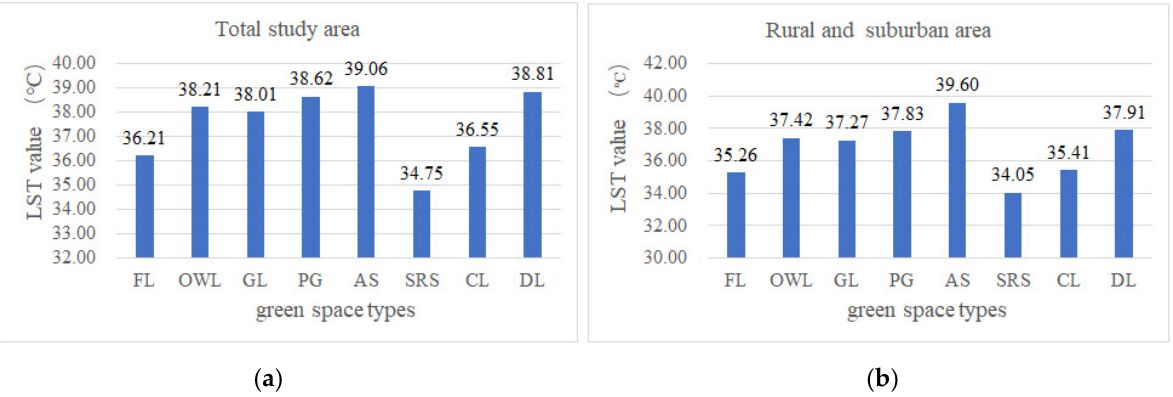
Figure 6. The mean surface temperature of different greenspace types. ( a ) The values in the study area; ( b ) the values in rural areas and SUA.